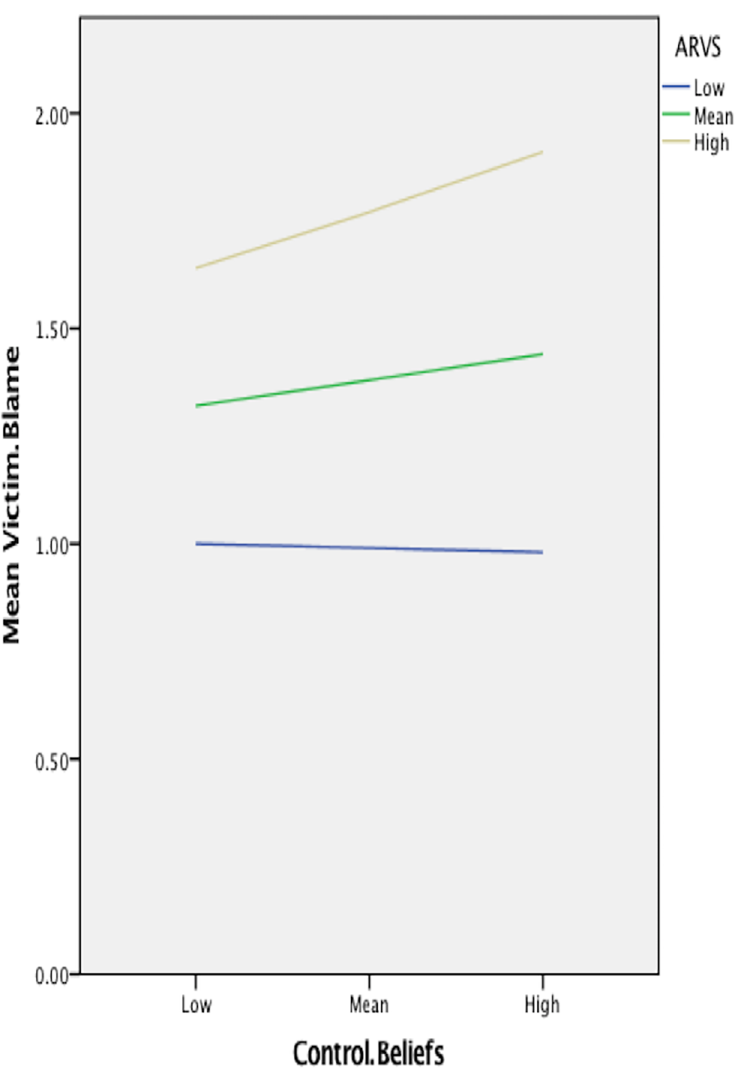
Fig 1. Simple slopes equations of the regression of victim blame on control beliefs at three levels of rape myth acceptance.